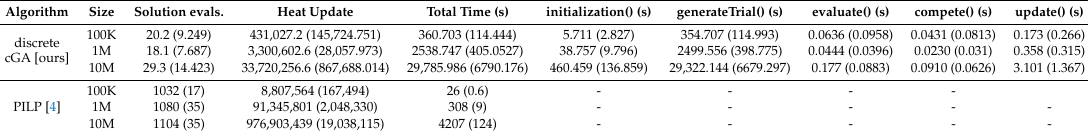
Table 7. Casting scheduling problem: number of solution evaluations to reach the optimum, number of heat updates, and execution times (mean across 10 runs, std. dev. in parentheses). The results for the PILP algorithm are taken from Table 6 in [4]; the symbol ‘-’ indicates data not provided. Algorithm Size